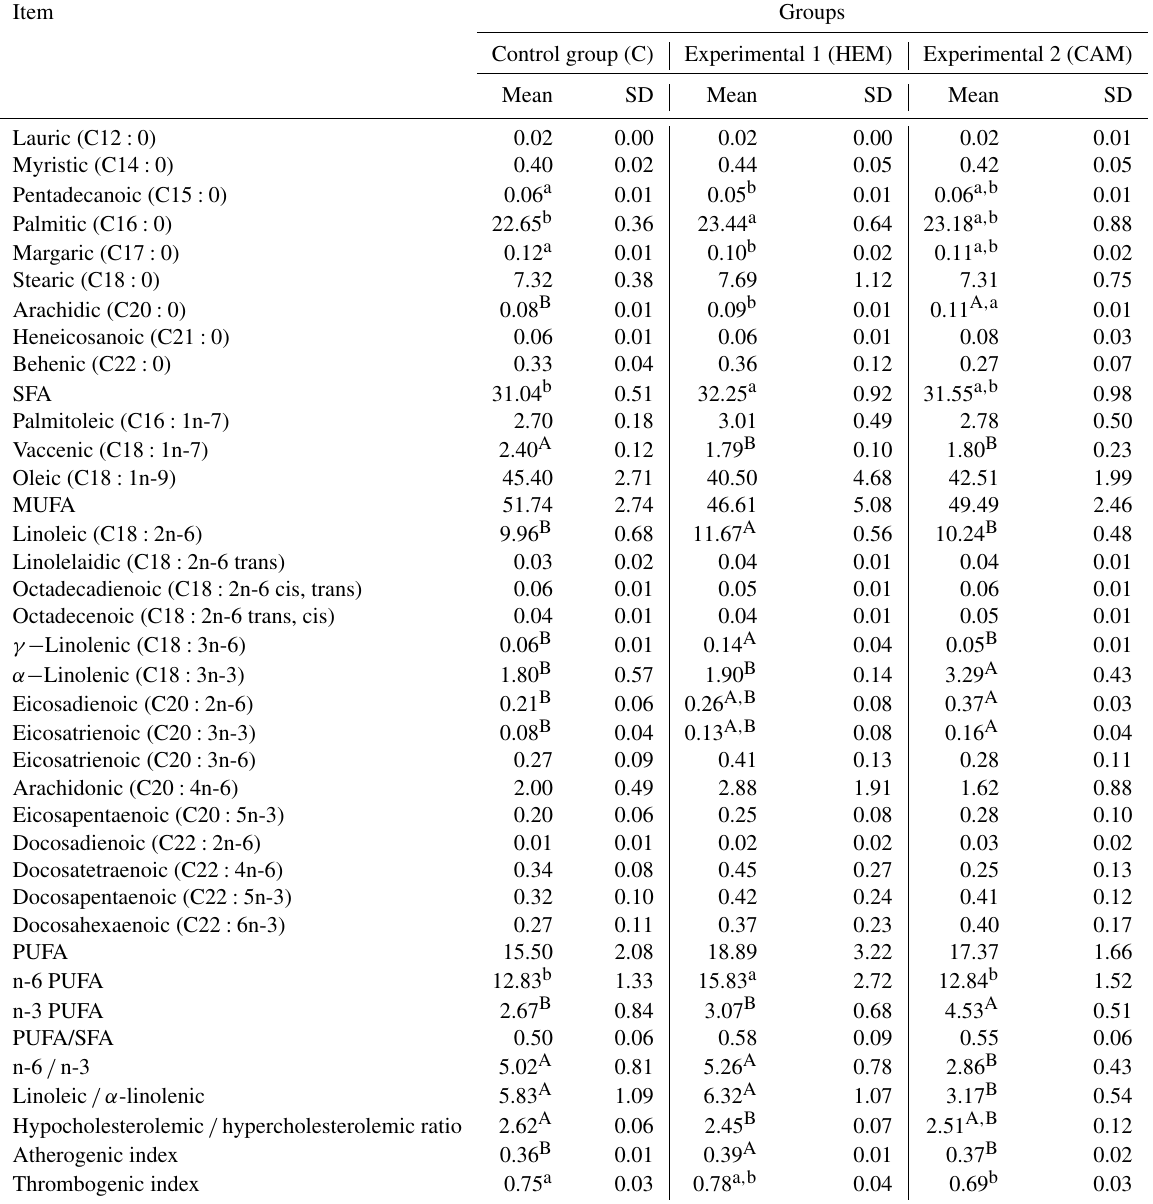
Table 3. The fatty acid composition of duck breast muscles (% of total fatty acids).